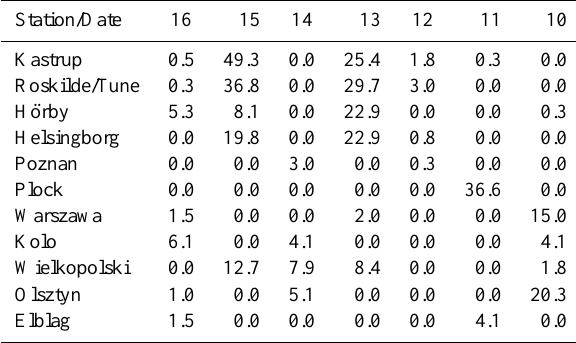
Table A2c. Daily measured precipitation in mmday − 1 in the poten- tial source region to the episodes of Alternaria spore concentrations (sporesm − 3 ) that were measured 15–16 August 2010. The last 7 days of recorded precipitation until the potential episode is used as an indicator of good harvesting possibilities. “–” usually means no precipitation was recorded, but could potentially also mean techni- cal problems.